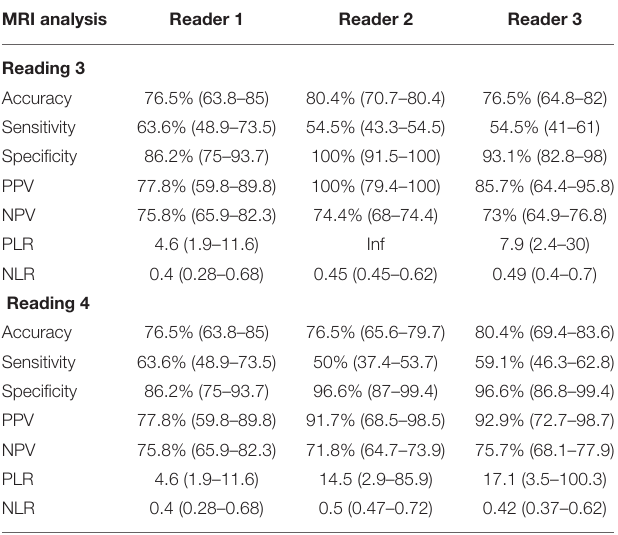
TABLE 3 | Value of high–signal–intensity spots on 3DT1FS in the diagnosis of vaginal